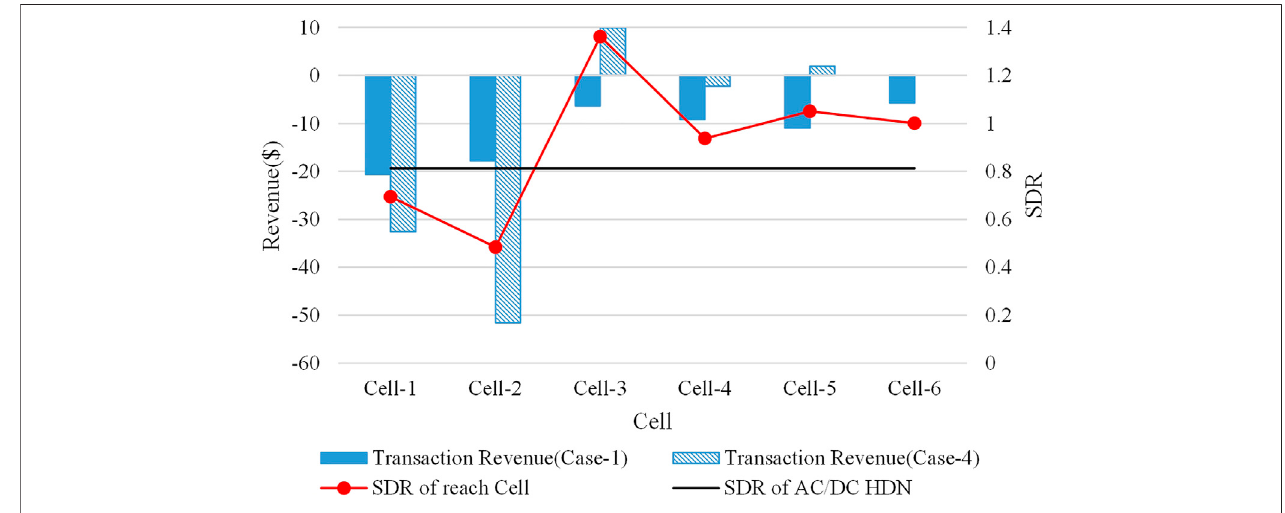
FIGURE 7 | Transaction revenue of each Cell at 10:00 in Case-1and Case-4.